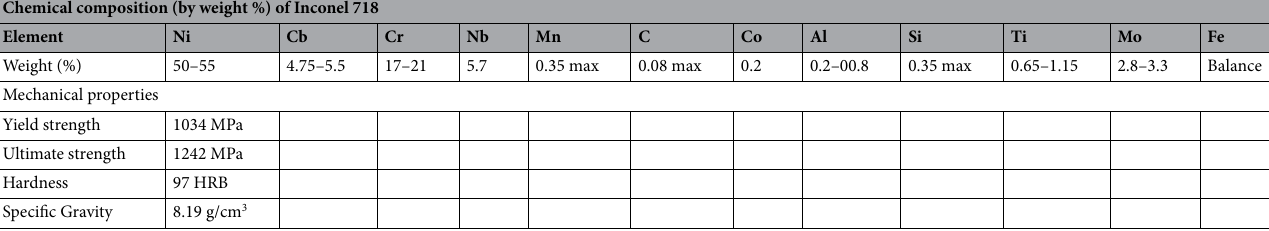
Table 1. Chemical and mechanical properties of Inconel 718.